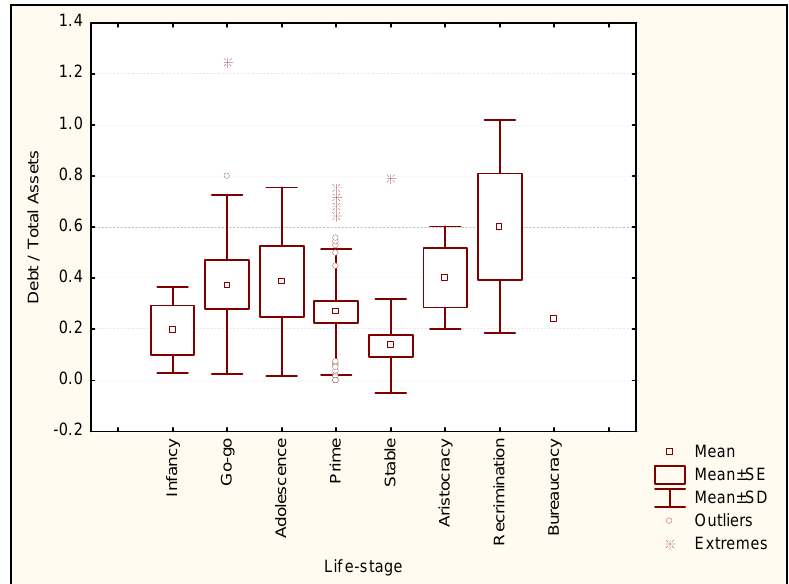
Figure 1: Box and whisker plot of respondents classified per life stage to debt/total assets